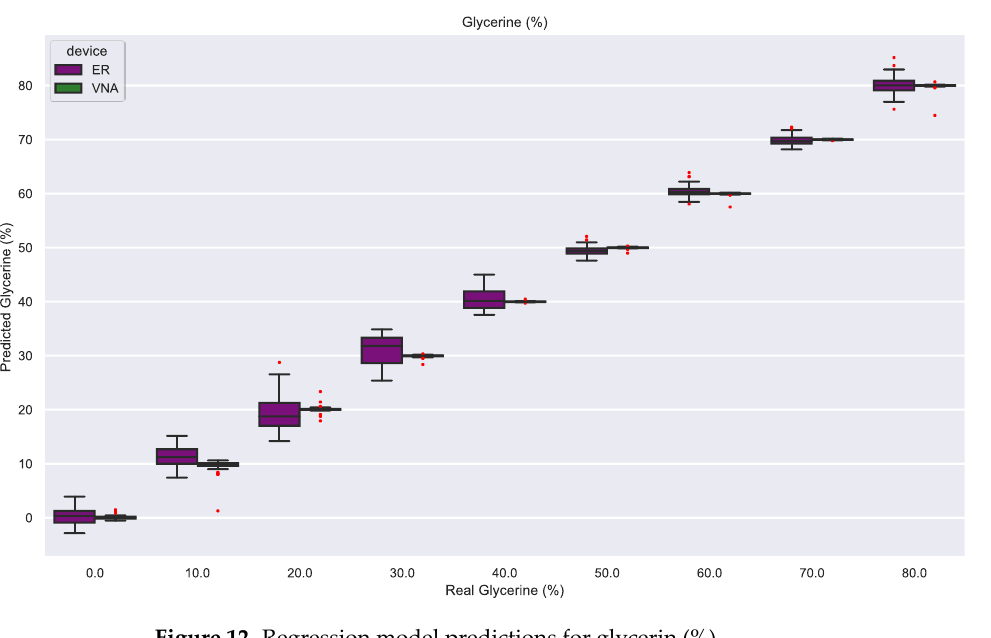
Figure 12. Regression model predictions for glycerin (%).